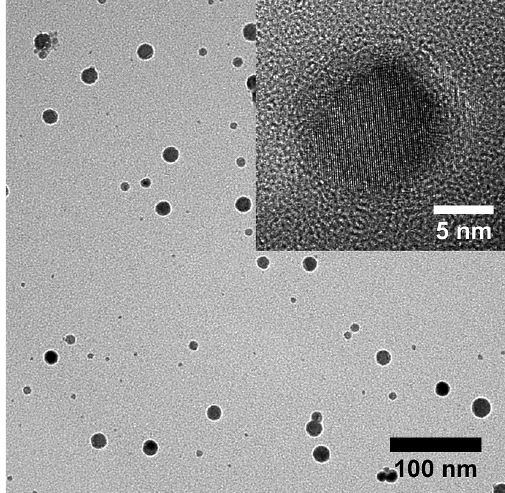
Fig. 7 TEM micrographs of copper nanoparticles. The inset shows a high-resolution micrograph of a nanoparticle with crystalline